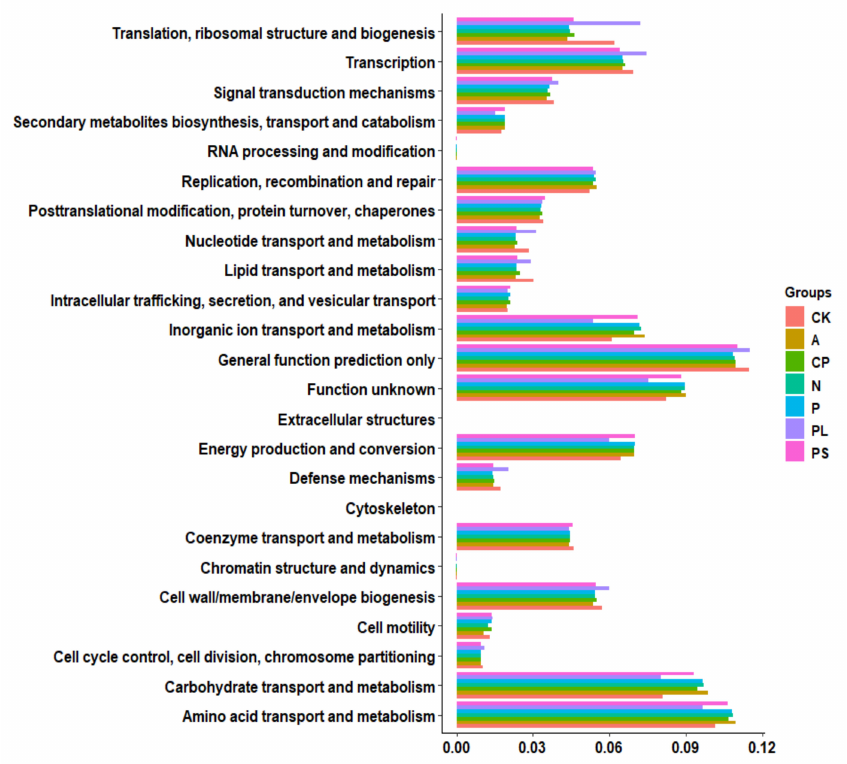
Figure 8. Comparison of predicted COG functions of gut bacteria of G. molesta feeding on different host